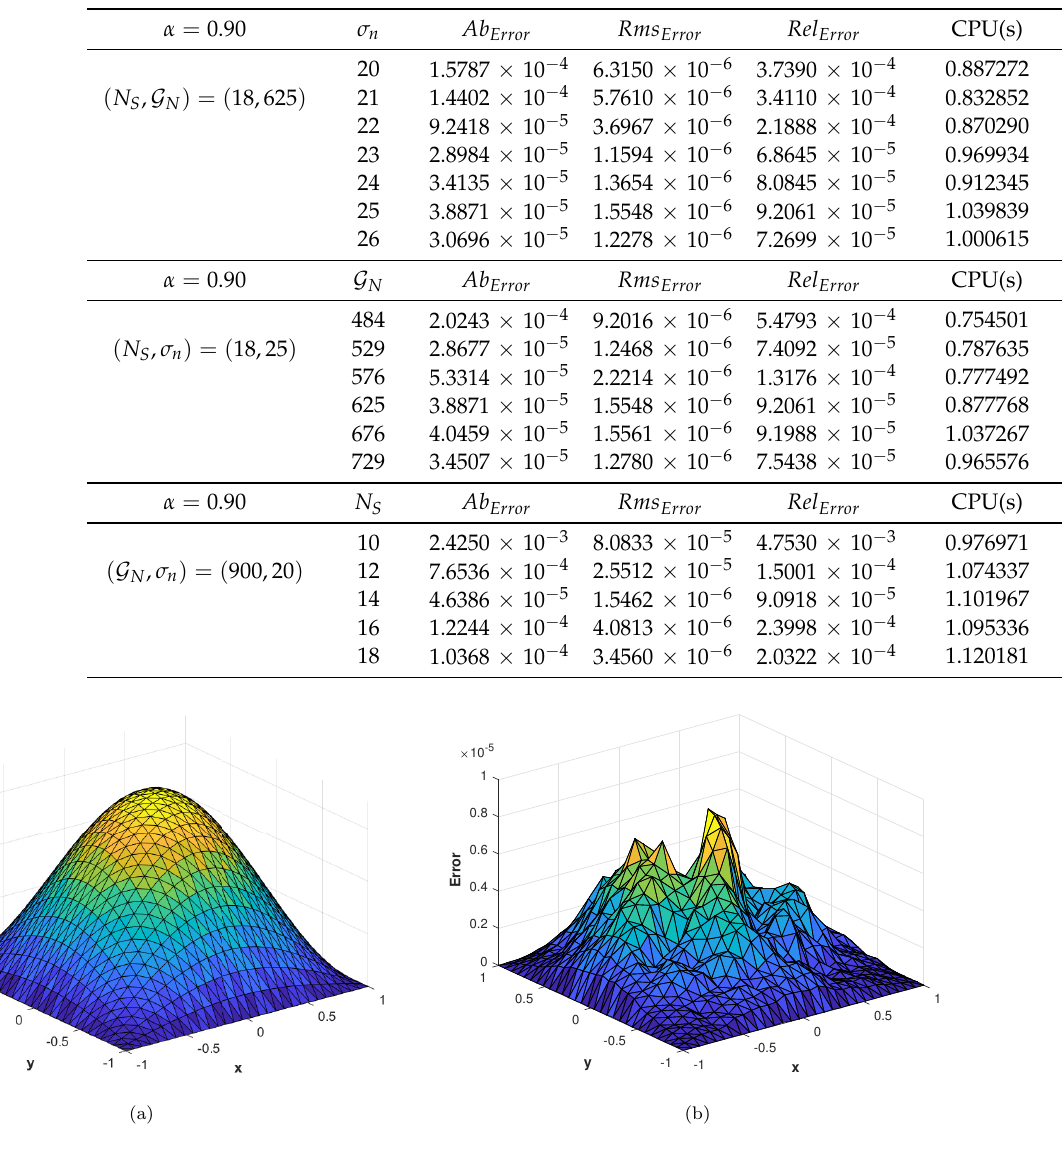
= 900 , N S = = 900, G N G N